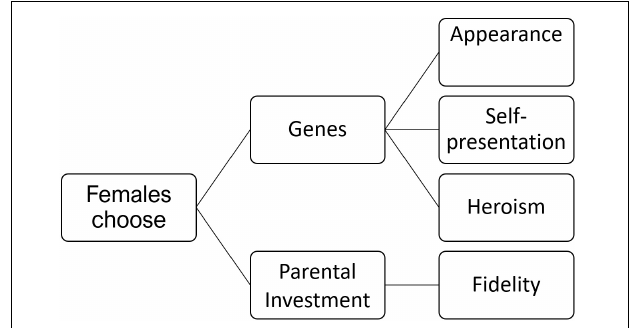
FIGURE 1 | Four classes of female choice. Beside choosing heroism (which explains altruism, see section “The Toy Model”) and self-presentation (which explains the evolution of language, see section “The Noise That Finally Improved the Channel”) there are two more classes which slow down the processes described in sections “The Toy Model” and “The Noise That Finally Improved the Channel”: choosing appearance (selecting health and beauty) and choosing fidelity and kindness (selecting parental